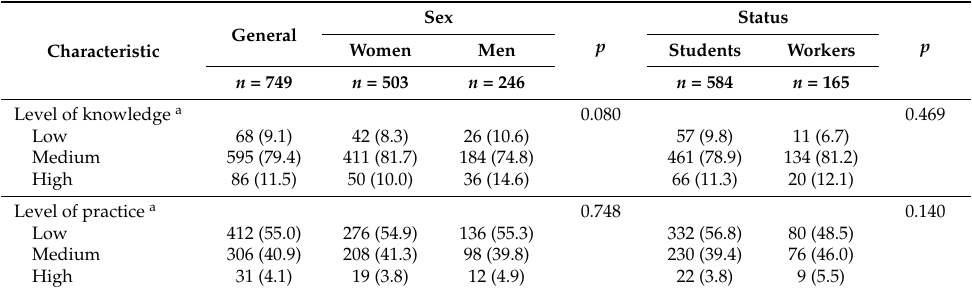
Table 4. Participant’s level of knowledge and practice when considering sex and status.